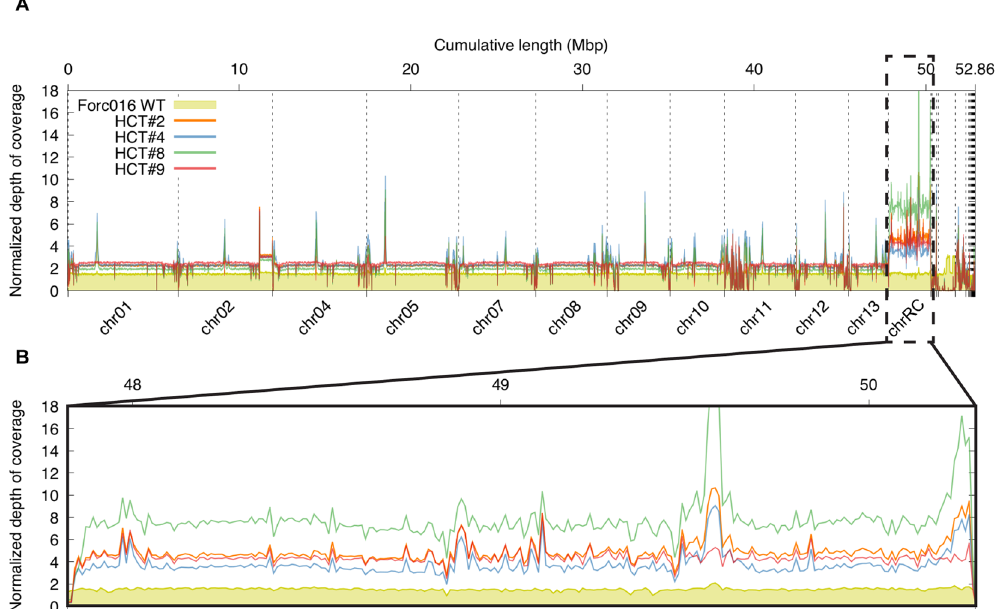
Figure 6. Normalized Illumina read mapping to the SMRT assembly of Forc016 confirms horizontal transfer of chr RC in a Fo47 background. ( A ) Reads mapped more abundantly to the transferred chr RC sequence than the rest of the assembly. ( B ) HCT strains #2, #4, #9 showed a relative (compared to total # mapped reads) depth of coverage of ~4 on chr RC , whereas the relative coverage of HCT#8 sequences was ~8 along the entire chromosome. This indicates a chromosomal duplication, in accordance with the ~5Mb-sized band in the CHEF gel in Fig.